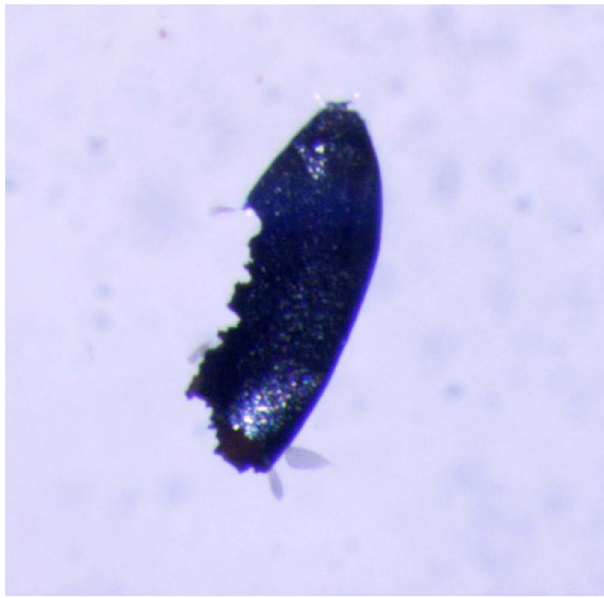
Figure 1. Mosquito egg showing severe damage. Photo by M. Zheng.